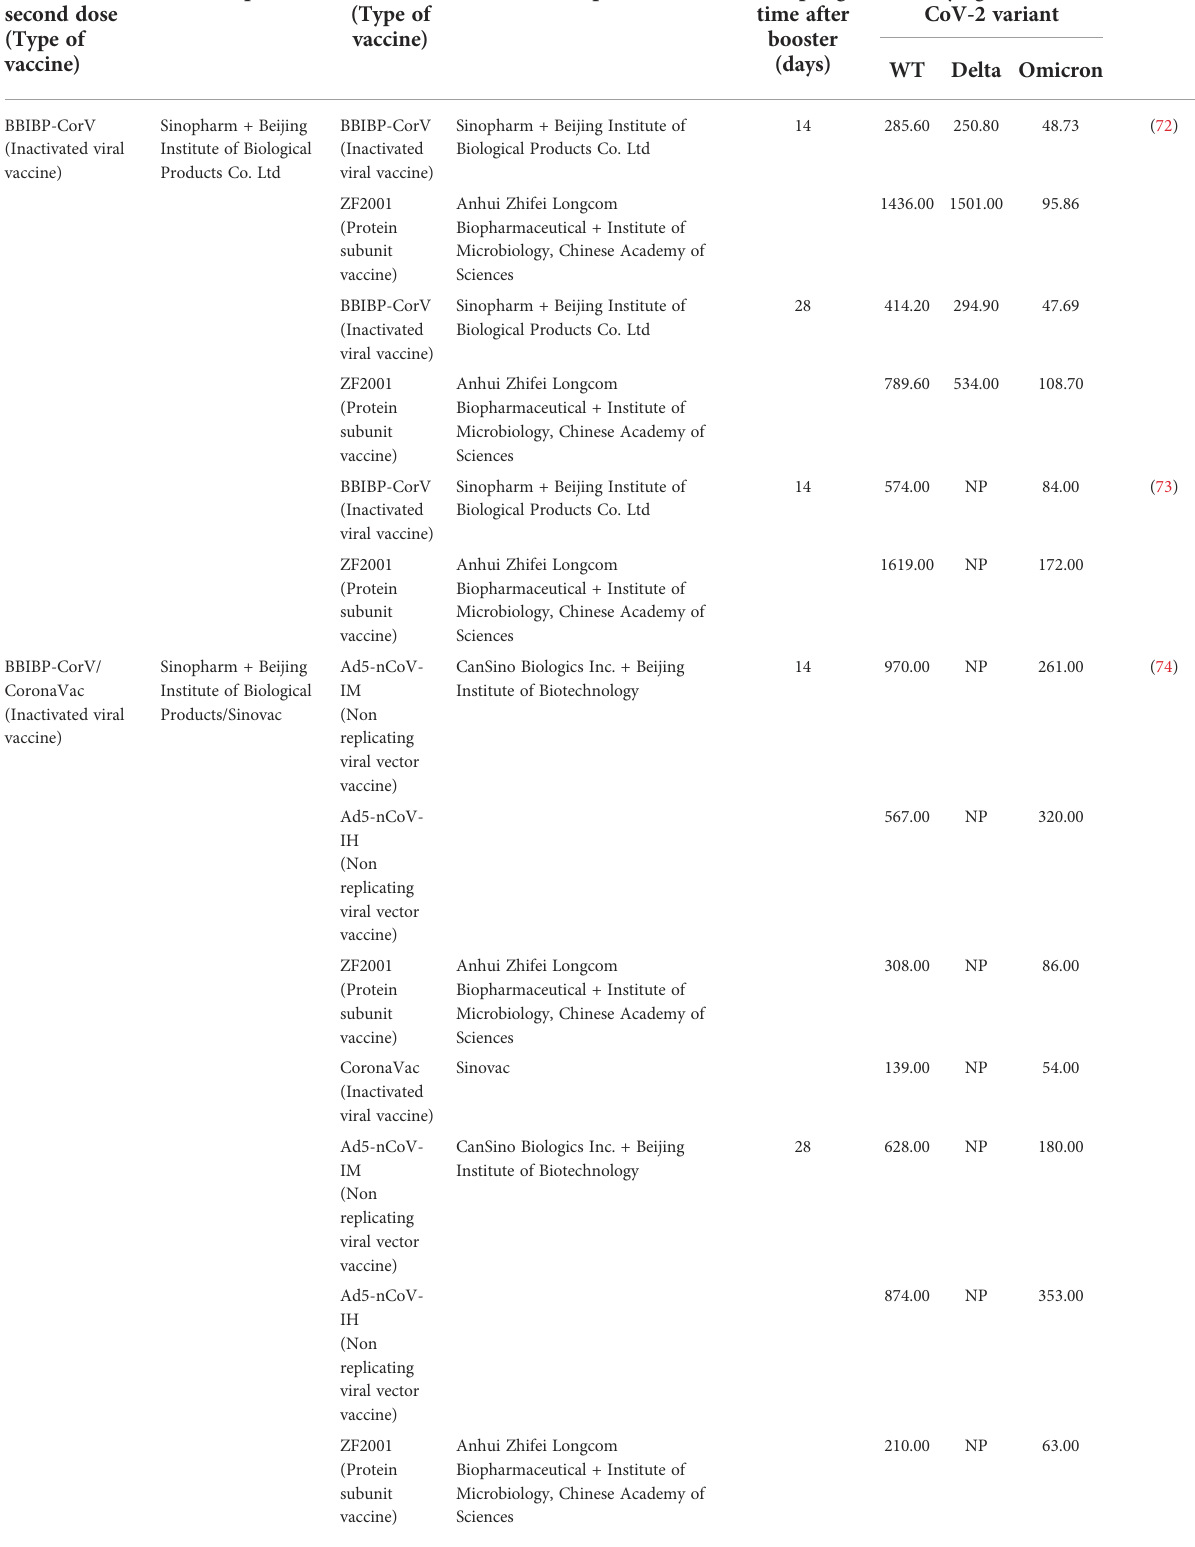
TABLE 2 Comparison of geometric mean titer between heterologous and homologous